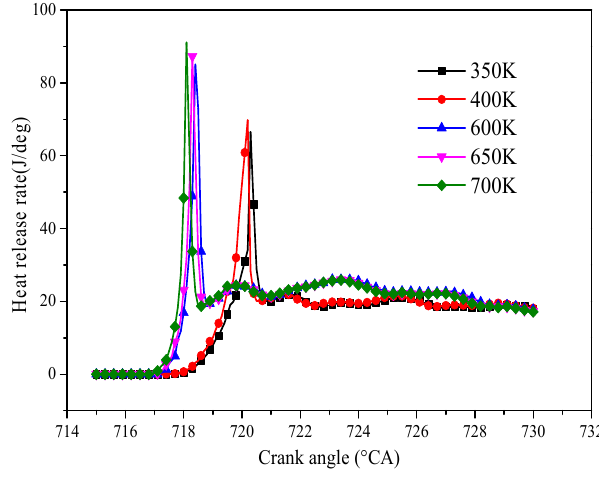
Figure 6. Change in heat release.